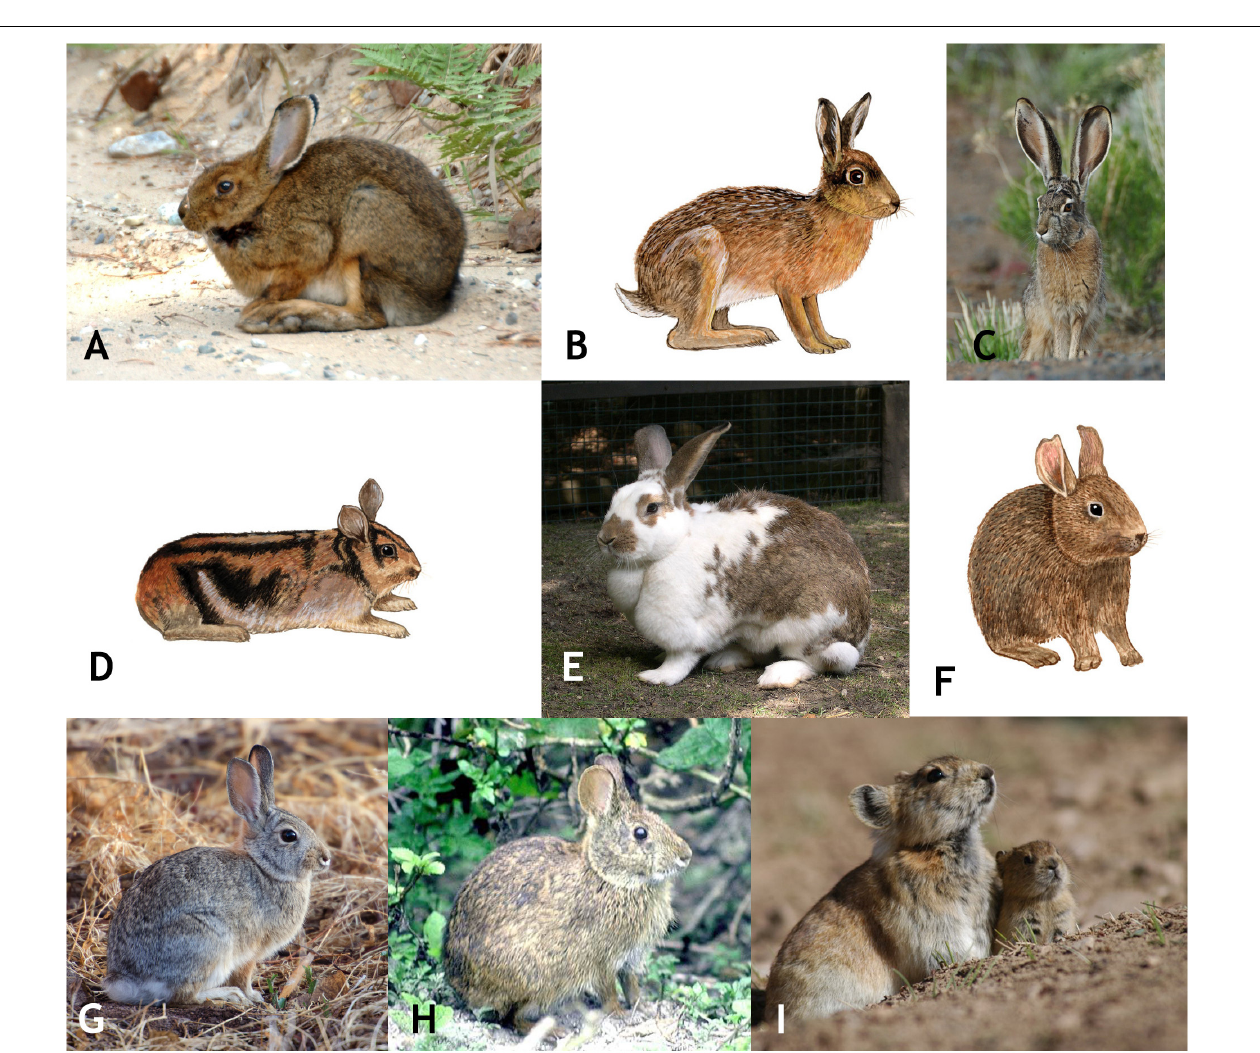
FIGURE 1 | A representative selection of extant lagomorphs, including: (A) Lepus americanus (snowshoe hare); (B) Lepus europaeus (European hare); (C) Lepus californicus (Black-tailed jackrabbit); (D) Nesolagus timminsi (Annamite striped rabbit); (E) Oryctolagus cuniculus (European rabbit); (F) Romerolagus diazi (Volcano rabbit); (G) Sylvilagus audubonii (Audobon’s cottontail); (H) Sylvilagus palustris (Marsh rabbit); (I) Ochotona curzoniae (Black-lipped pika). All images from Myers et al. (2020).